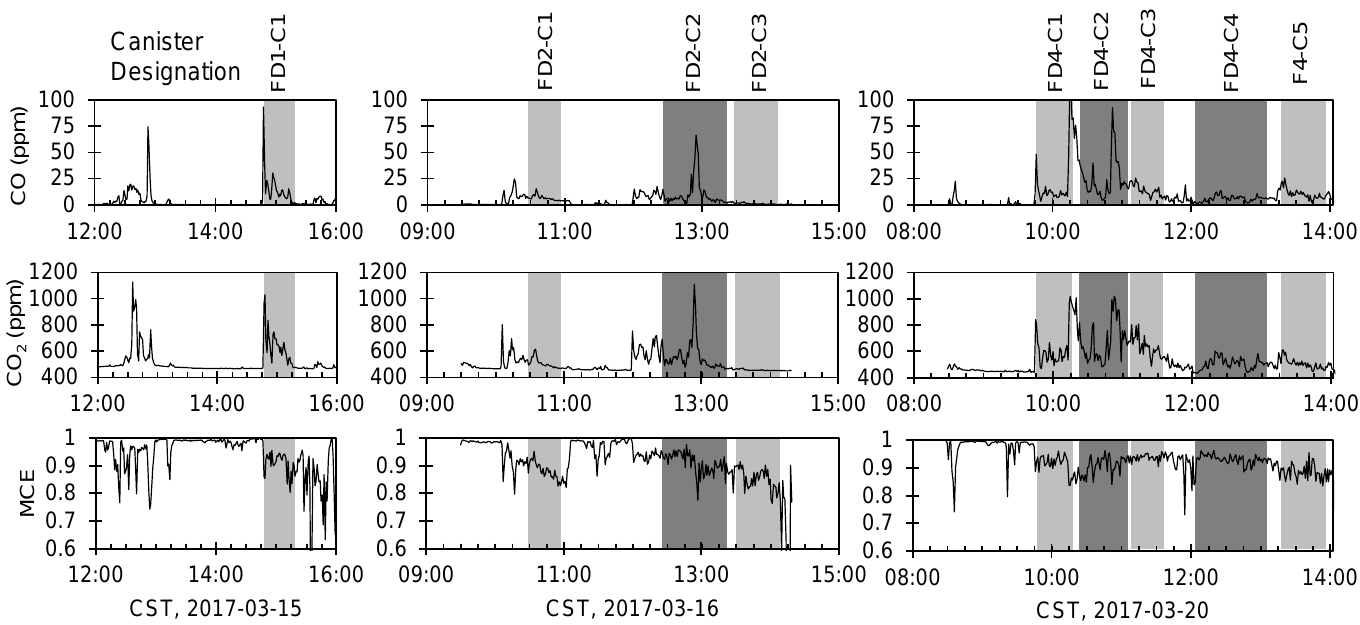
Figure 2. Continuous timeseries of CO, CO 2 , and MCE for the three days we sampled VOC canisters. Canister sampling periods are shaded and labeled with the canister designation above the CO